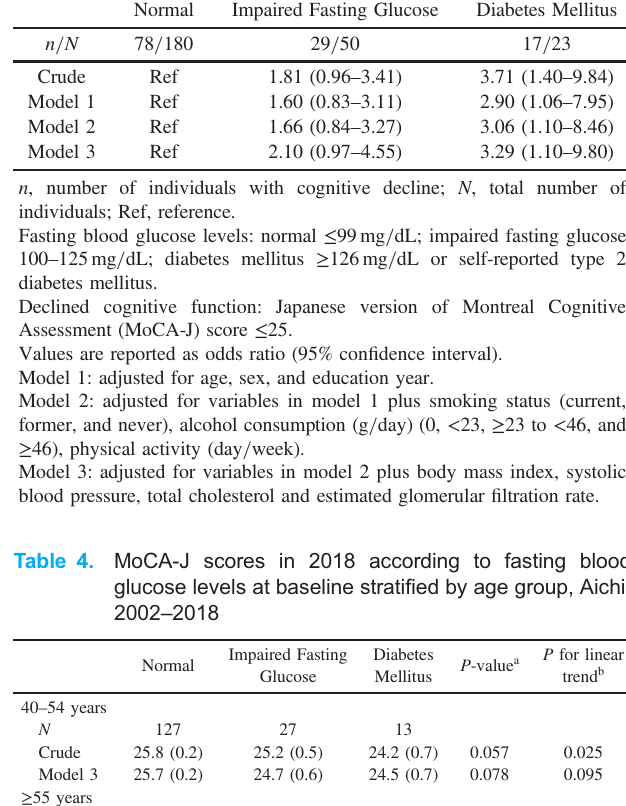
Table 3. Odds ratios and the 95% con fi dence intervals for declined cognitive function according to fasting blood glucose levels at baseline, Aichi, 2002 – 2018 Normal